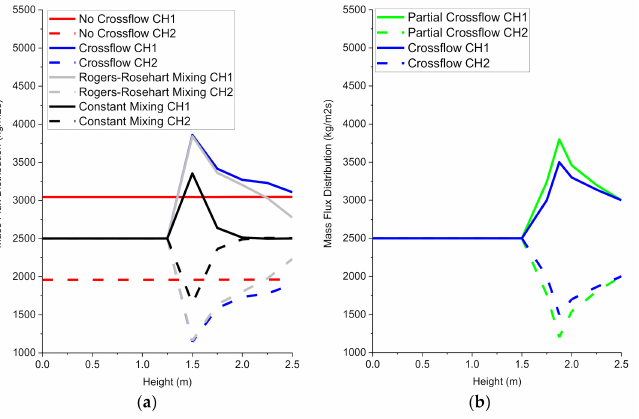
Figure A7. ( a ) CTF mass-flux axial distributions; ( b ) FLOCAL mass-flux axial